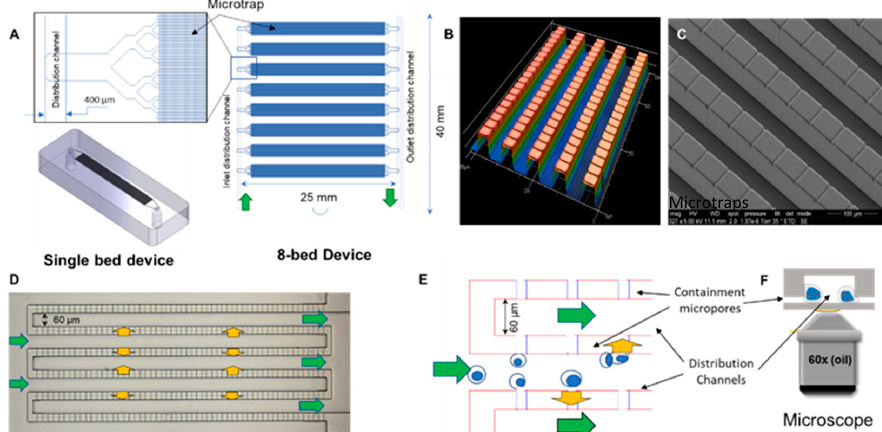
Figure 1. Microfluidic device for performing automated immunophenotyping and FISH. ( A ) Design of the microfluidic network composed of a single bed with 7200 microtraps and the 8-bed device containing 10,000 microtraps in each bed for a total of 80,000 traps per device. Microtrap size: 4 × 2 × 50 µm (w × d × l). ( B ) Profilometer scan of the microtrap chip replicated in PDMS from a 3-level SU-8 relief and a Si master showing microchannel depth varying between input/output distribution channels, interleaving channels, and cross-channels. ( C ) Cross-channels and the deeper interleaving channels are shown in the SEM image. ( D ) Optical microscope image of a lithographically patterned 2-level SU-8 relief for preparing a single bed microtrap device. The arrows show the fluid path. ( E ) Schematic showing operation of the microtrap chip. Cells in solution (green arrows) are contained at the entrances of the microtraps, letting the fluid pass (yellow arrows) into the outlet channels of the interleaving network. ( F ) Schematic showing the 3-dimensionality of cells captured in the microtrap chip and imaging using a high magnification (60× or 100×) objective through a thin cover plate.